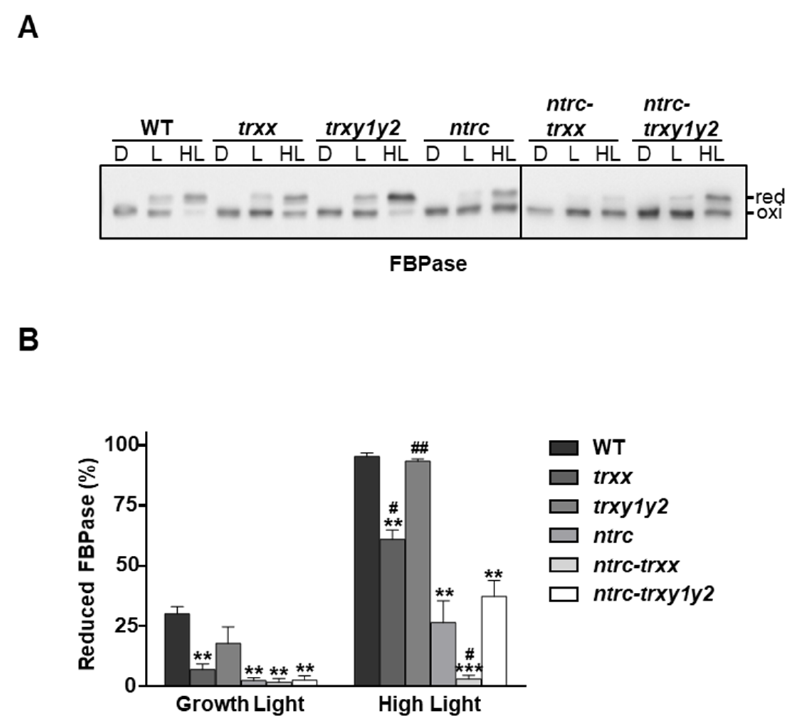
Figure 4. In vivo redox state of FBPase in mutant plants devoid of Trxs y . Plants of the wild type and mutant lines, as indicated, were grown under long day conditions for 4 weeks. Whole rosettes were harvested at the end of the period of darkness (D) and then illuminated for 30 min with light intensities of 125 µ E m − 2 s − 1 (growth light, L) or 450 µ E m − 2 s − 1 (high light, HL). ( A ) The in vivo redox state of FBPase was determined by alkylation using the thiol-labelling agent iodoacetamide (IAA). Protein extracts were subjected to SDS–PAGE under non-reducing conditions, transferred onto nitrocellulose filter and probed with an anti-FBPase antibody. ( B ) Band intensities were quantified (GelAnalyzer), and the percentage of reduction was calculated as the ratio between the reduced form and the sum of oxidized and reduced forms. Each value is the mean of three independent experiments ± standard error (SE). Statistical significance compared with the wild type (asterisks) or the ntrc mutant (hashes) is indicated (#, p < 0.05; ** and ##, p < 0.01; ***, p < 0.001, Student’s t test); red, reduced; oxi, oxidized.